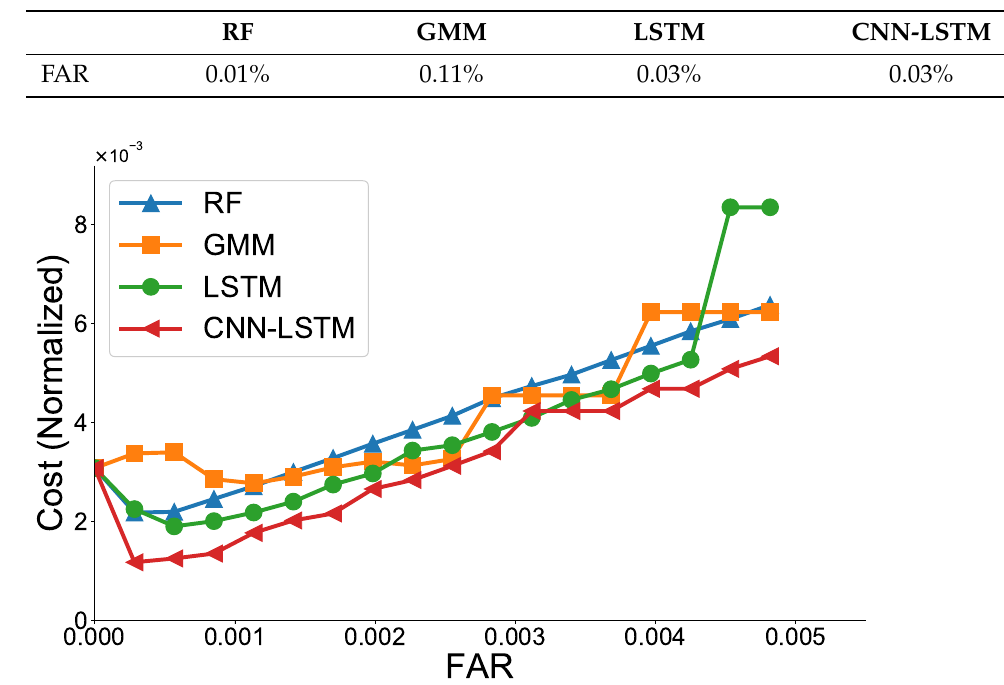
Table 5. FAR values with the minimum cost for various ML models.